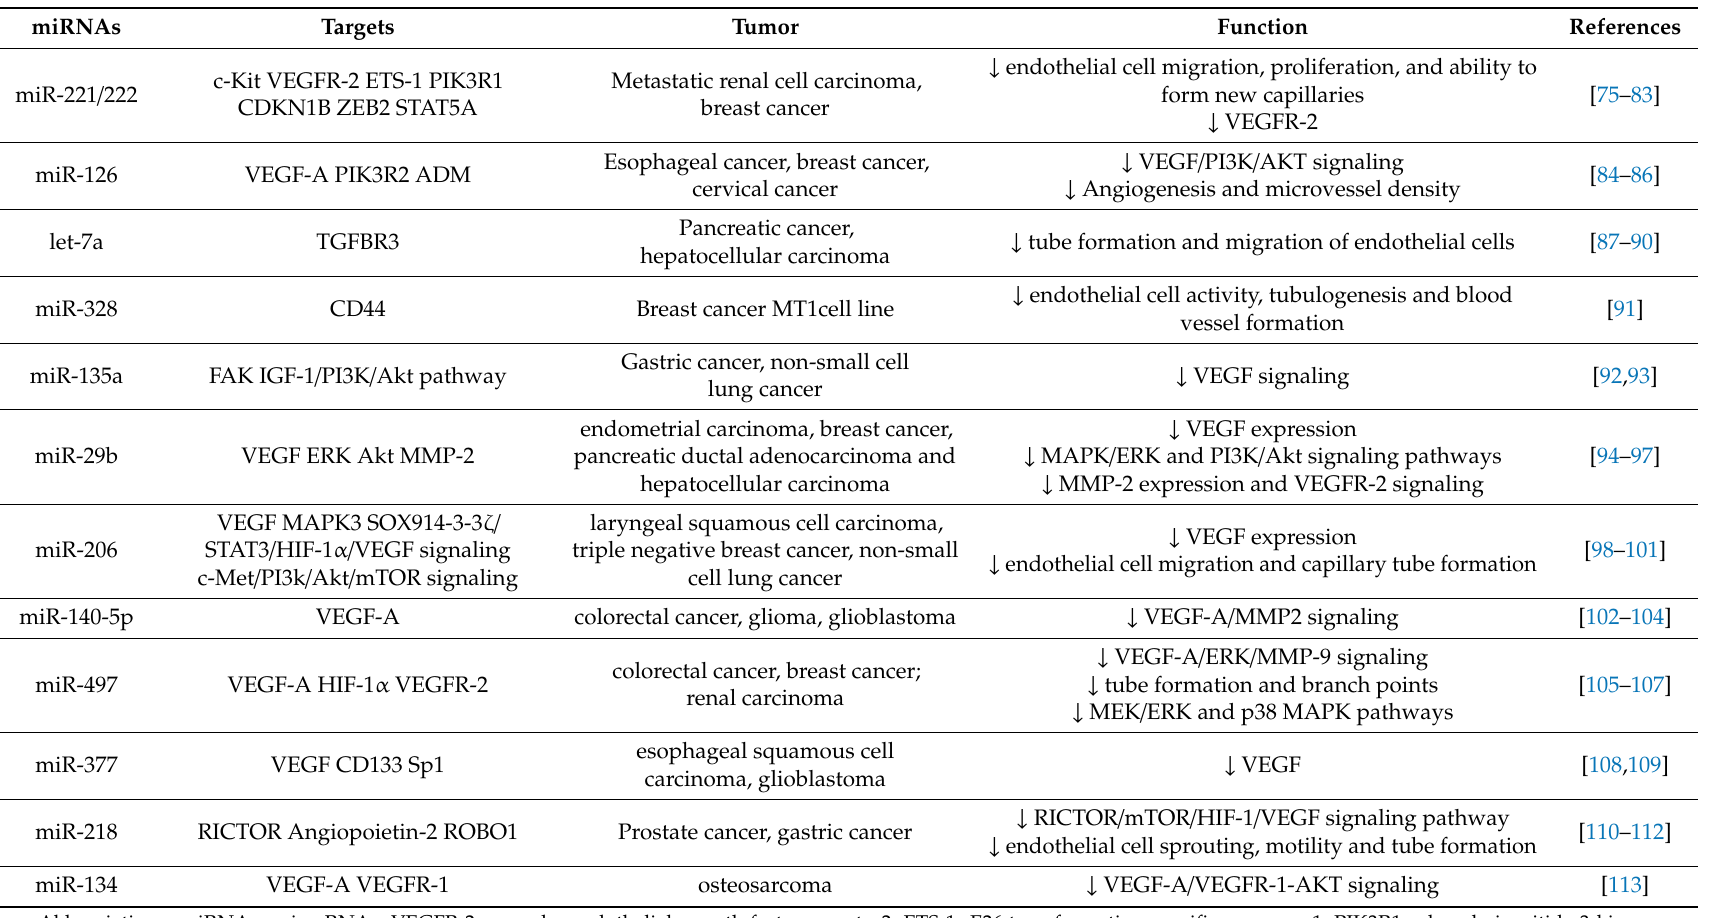
Table 2. Summary of anti-angiogenic miRNAs involved in tumor angiogenesis